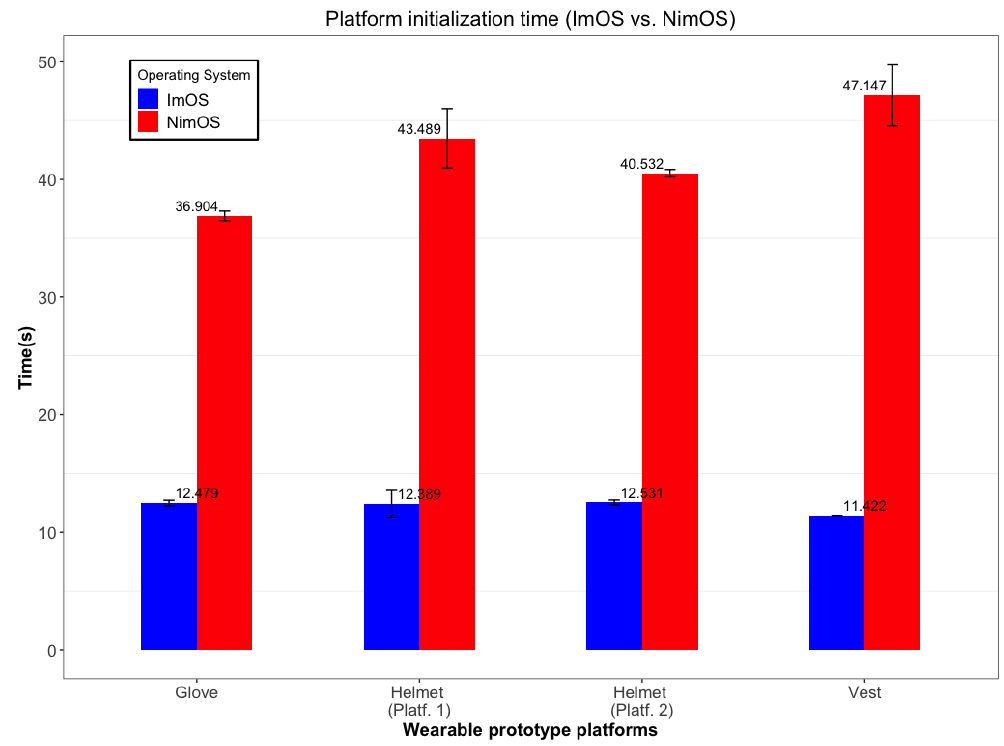
Figure 11. ImOS vs. NimOS: initialization time of all wearable